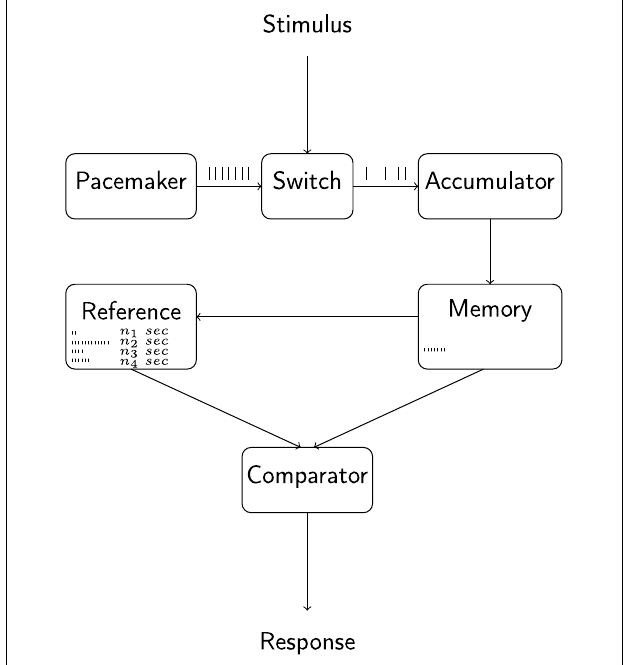
FIGURE 1 | Outline of the internal clock model of interval timing. The pacemaker emits pulses at a rate that depends on organismic state and is hypothesized to be under the control of circadian and sleep-homeostatic processes. Pulses are gated into the accumulator and working memory components via an attention-controlled switch and attentional lability may lead to a leakage of pulses at this stage. The comparison of working memory contents with a reference memory containing pulse-duration associations formed during previous experiences constitutes the basis for overt behavior. Adapted from Wearden (unpublished